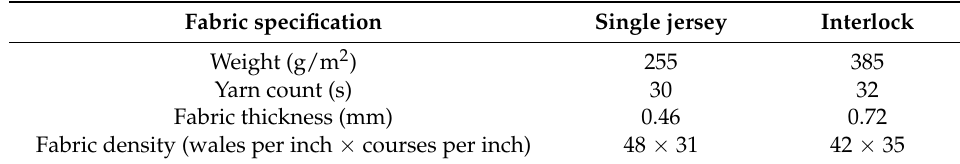
Table 1. Specifications of 100% grey cotton knitted